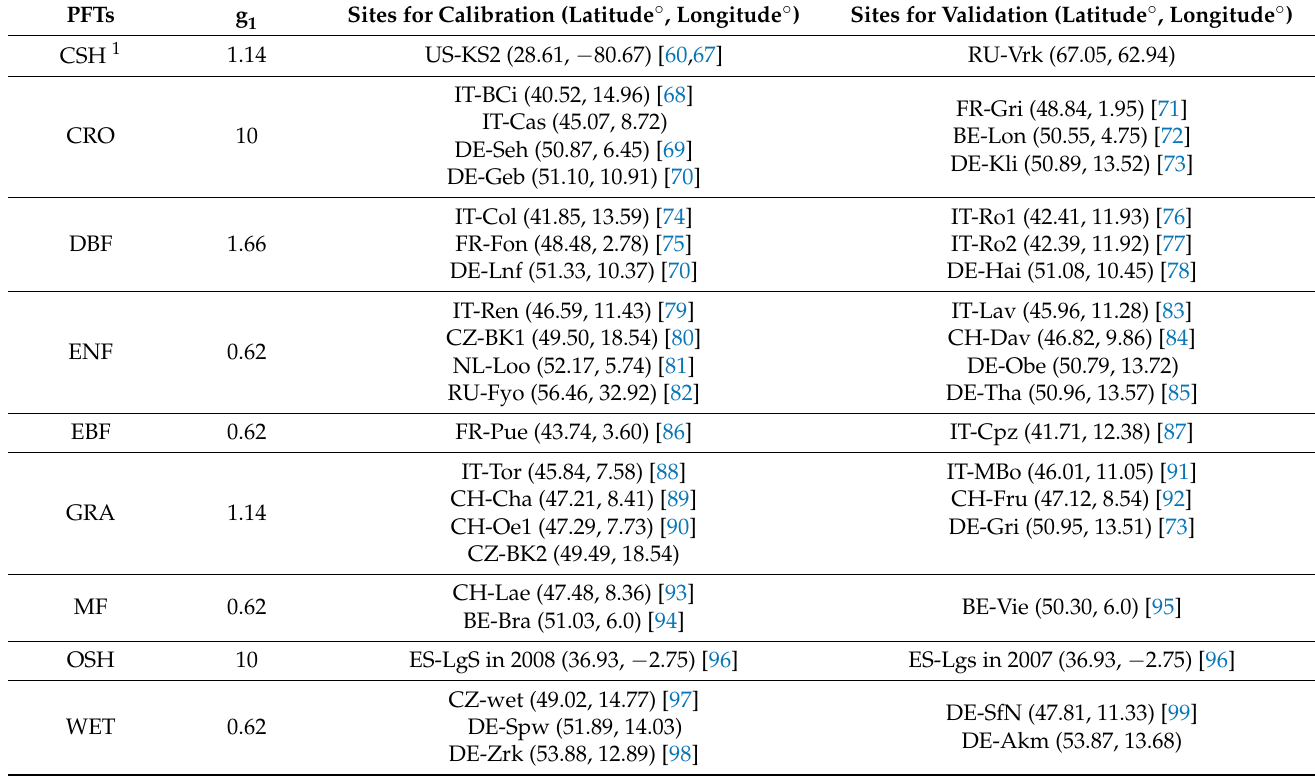
Table 1. Sites for model calibration and validation and the calibrated g types